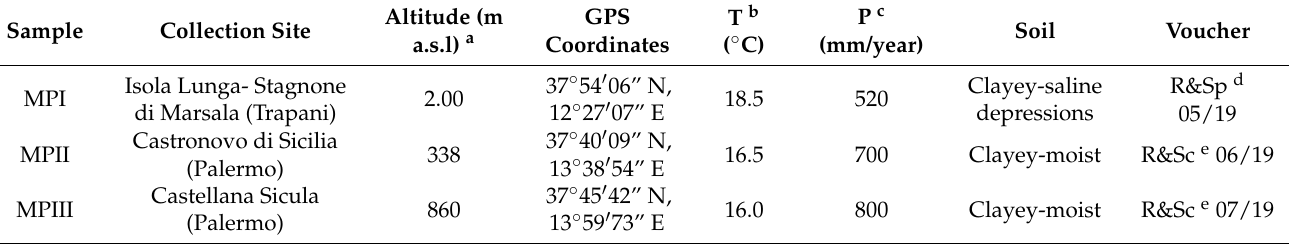
Table 4. Data on collection sites of M. pulegium L. wild populations in the Sicily region ( n = 3 for each collection